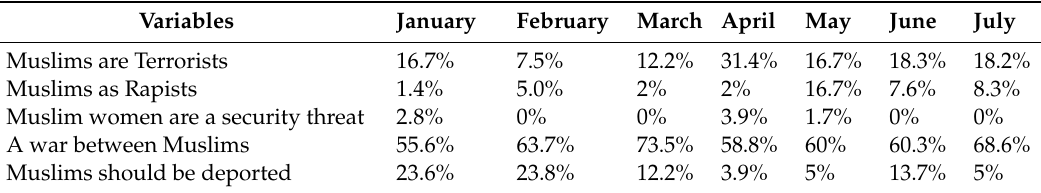
Table 3. Variable frequency